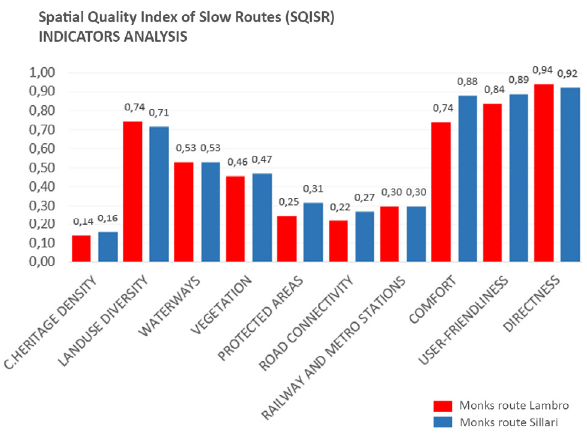
Figure 6. Histogram with the indicators analysis.